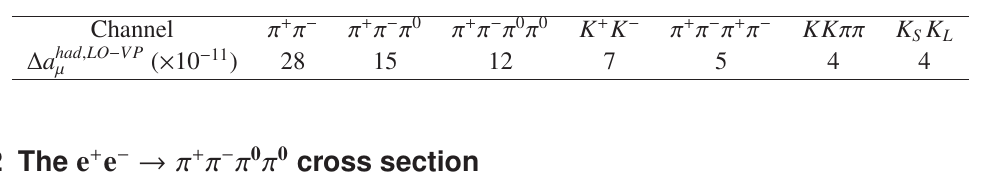
Table 2. Exclusive e + e − → hadrons channels contributing the largest uncertainty Δ a had , LO − VP μ to the SM prediction of the muon anomaly term a had , LO − VP μ (taken from Ref.